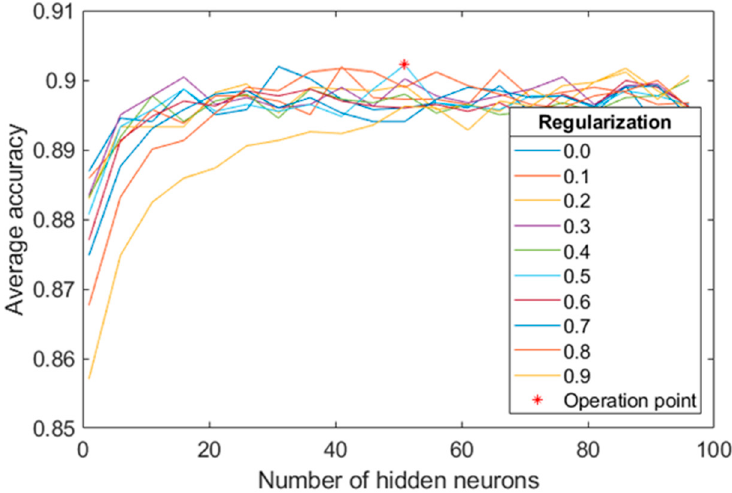
Figure 6. Average accuracy for RL classification over the validation set obtained during MLP training for varying the number of hidden neurons and the regularization parameter.